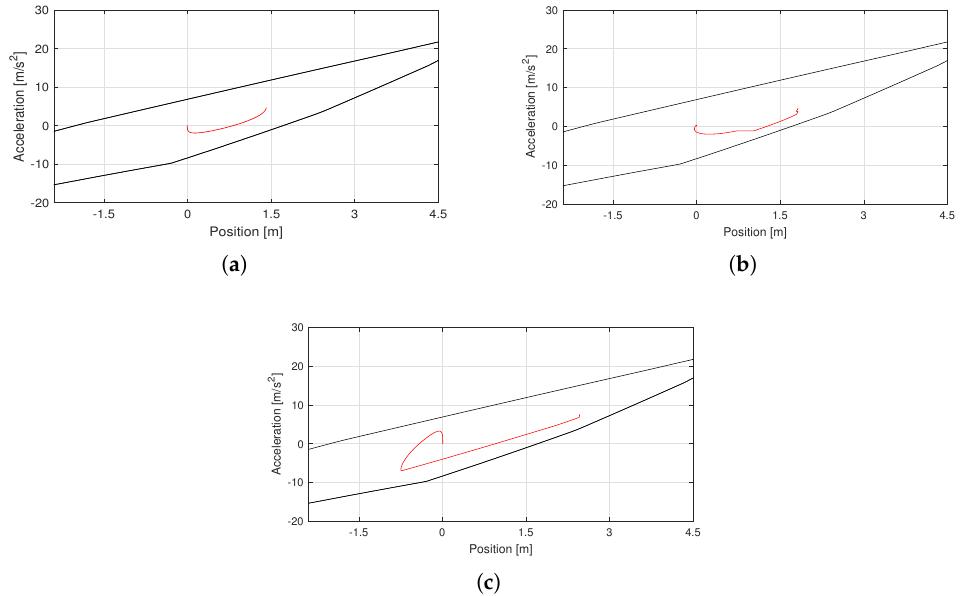
Figure 8. Motion law obtained with the proposed method when changing the distance from SP.( a ) Distance: 1.3 m; ( b ) Distance: 1.7 m; ( c ) Distance: 2.2